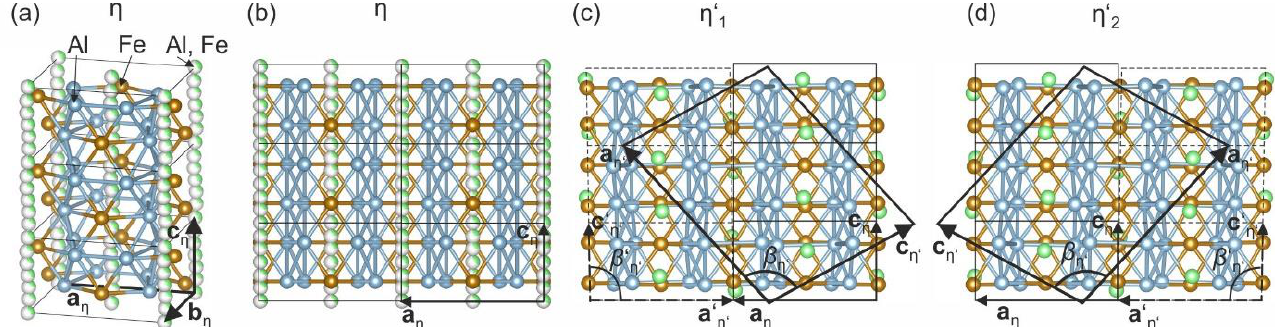
Figure 1. ( a ) Illustration of the crystal structure of the disordered, orthorhombic η -Al 5 Fe 2 phase based on the structure model by Burkhardt et al. [33] modified by [30] with green atoms as the channel atoms (Al, Fe). Their partial occupancy is indicated by the degree of filling of the atomic spheres. Blue (Al) and orange (Fe) represent the atoms of the framework structure [30]. ( b ) View along the b - axis of the η -Al 5 Fe 2 phase. ( c , d ) Analogous view of the two principal ways (η′ 1 and η′ 2 ) in which ordered η′ -Al 8 Fe 3 phase can be formed from η following the reduction of the symmetry of the crystal class from mmm to 2/ m upon ordering (see Section 3.1). Additionally, the superstructure unit cell and the pseudo-orthorhombic subcell are indicated.